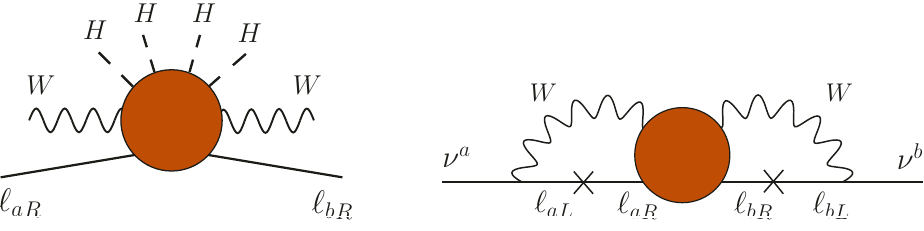
from eq. (2.1). Right: 2-loop neutrino mass from O 9